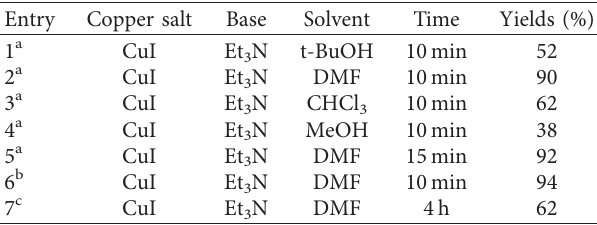
Table 1: Optimization of reaction condition 2a. Entry Copper